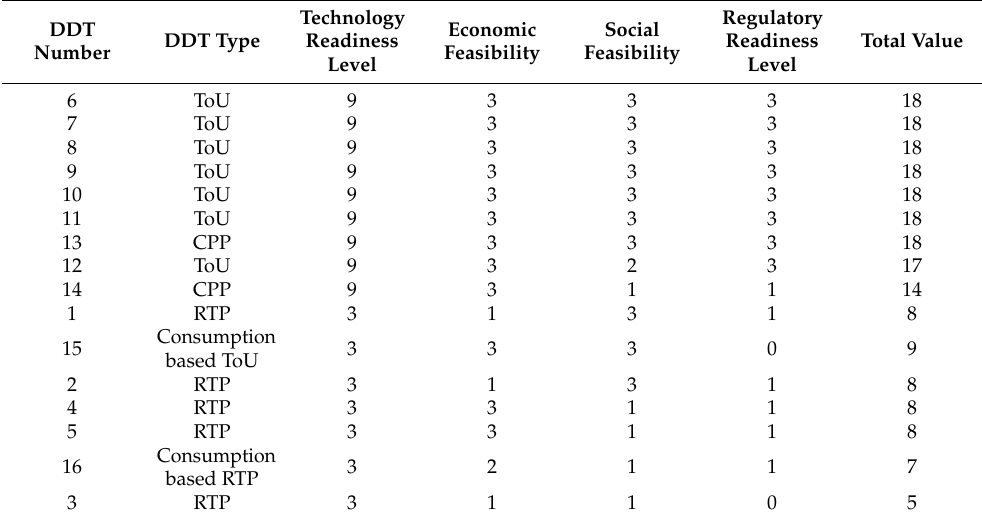
Table 10. Overview of the evaluation grades, all above the bold line are top graded in all